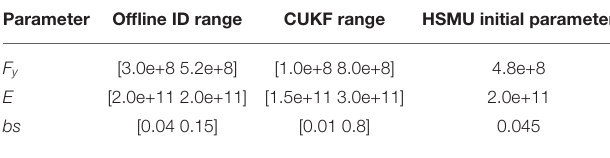
TABLE 2 | Model parameters of bilinear steel